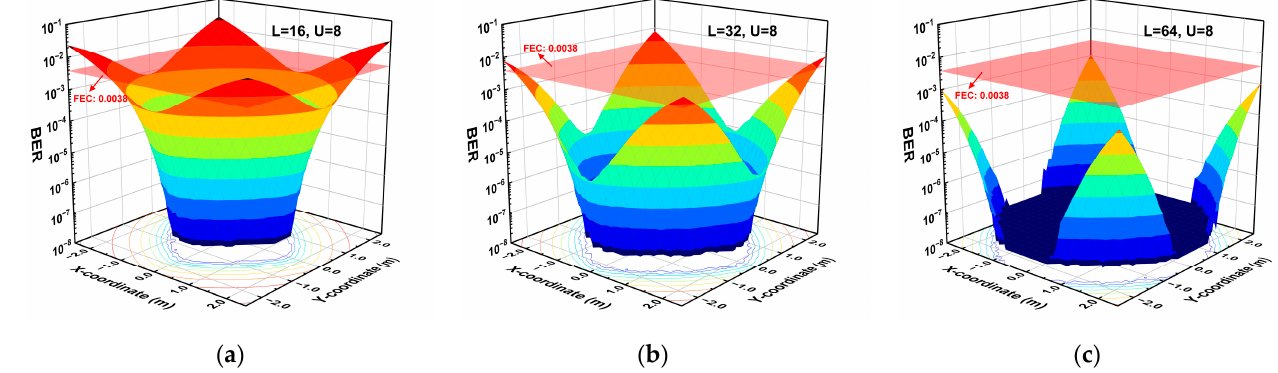
Figure 7. Surface diagram of BER estimated at all testing points of the 8-user VLCP system when the length of spreading code is ( a )16, ( b ) 32, and ( c ) 64.